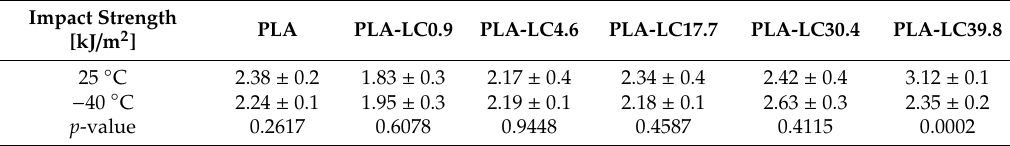
Table 1. The impact strength of the samples tested at di ff erent